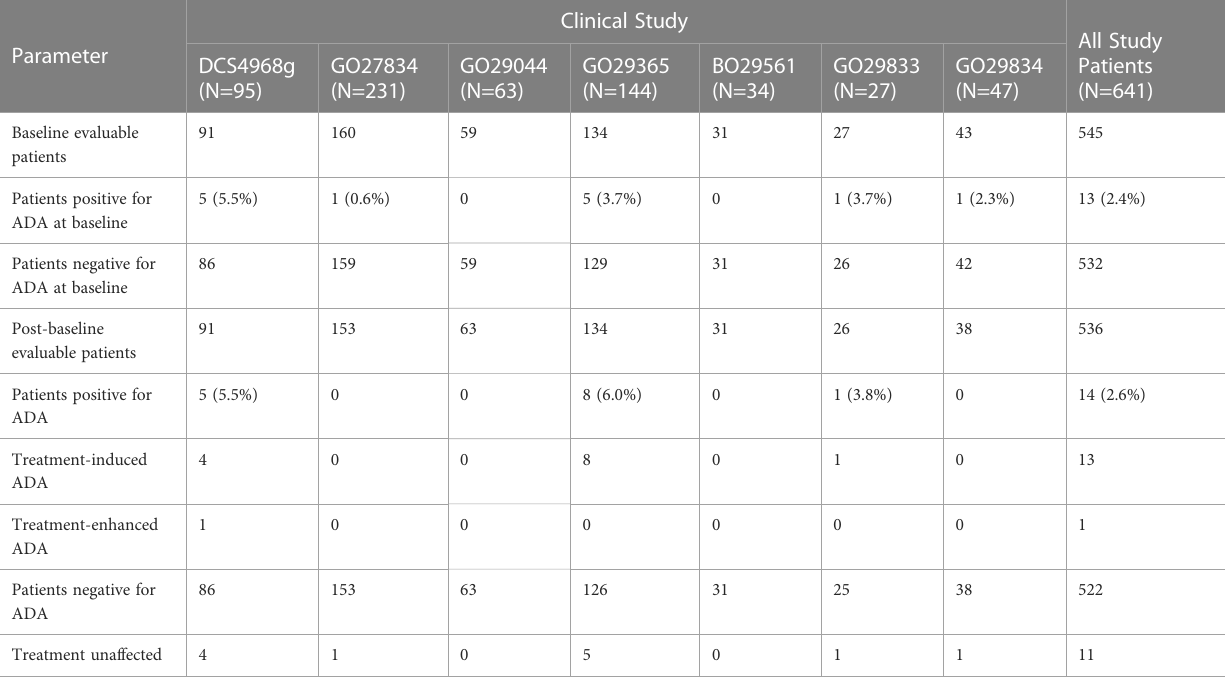
TABLE 4 Incidence of polatuzumab vedotin ADAs in studies DCS4968g, GO27834, GO29044, GO29365, BO29561, GO29833, and